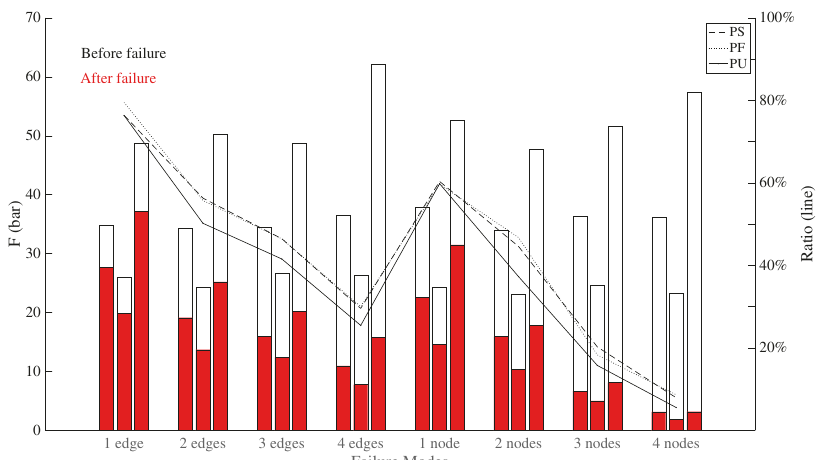
Fig. 7 Robustness of routing results against network failures. Comparing system throughput before and after the failure of the three scheduling schemes. Different failure modes (1 – 4 edges failure, 1 – 4 nodes failure) are simulated.